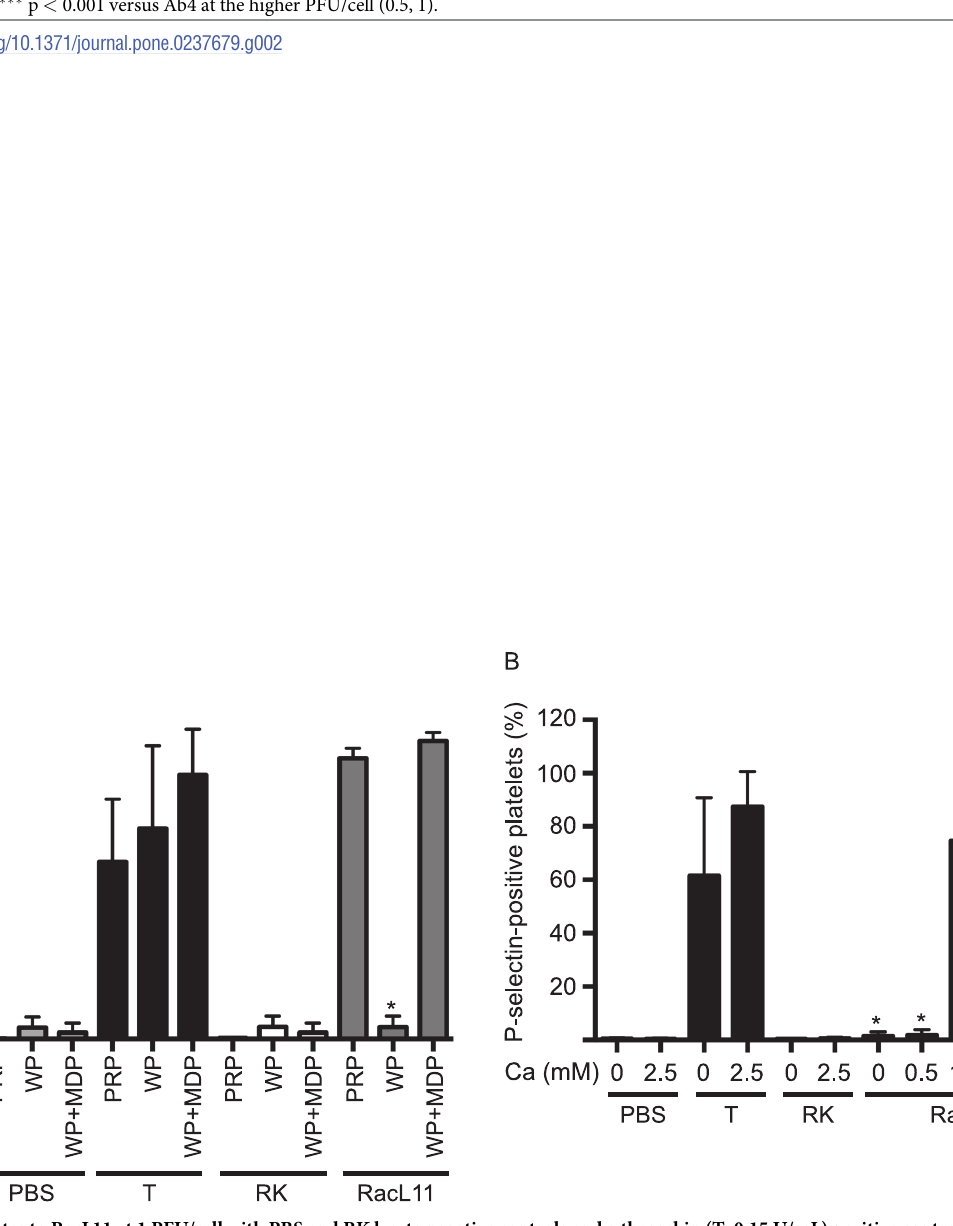
Fig 4. 10 minutes to RacL11 at 1 PFU/cell with PBS and RK lysate negative controls and a thrombin (T, 0.15 U/mL) positive control. Washed platelets did not express P-selectin when exposed to virus unless plasma was present. In contrast, thrombin-induced P-selectin expression was independent of plasma (n = 5). Data represents mean ± SD. � p < 0.001 versus PRP or WP + MDP for RacL11-exposed platelets. B : Effect of calcium: Equine citrate-anticoagulated PRP was exposed to RacL11 at 1 PFU/cell for 10 minutes with increasing calcium concentrations (0 to 2.5 mM), with the above controls. EHV-1-induced P-selectin expression required at least 1 mM of exogenous calcium (n = 3). Data represents mean ± SD. � p < 0.001 versus 1.0, 2.0 or 2.5 mM